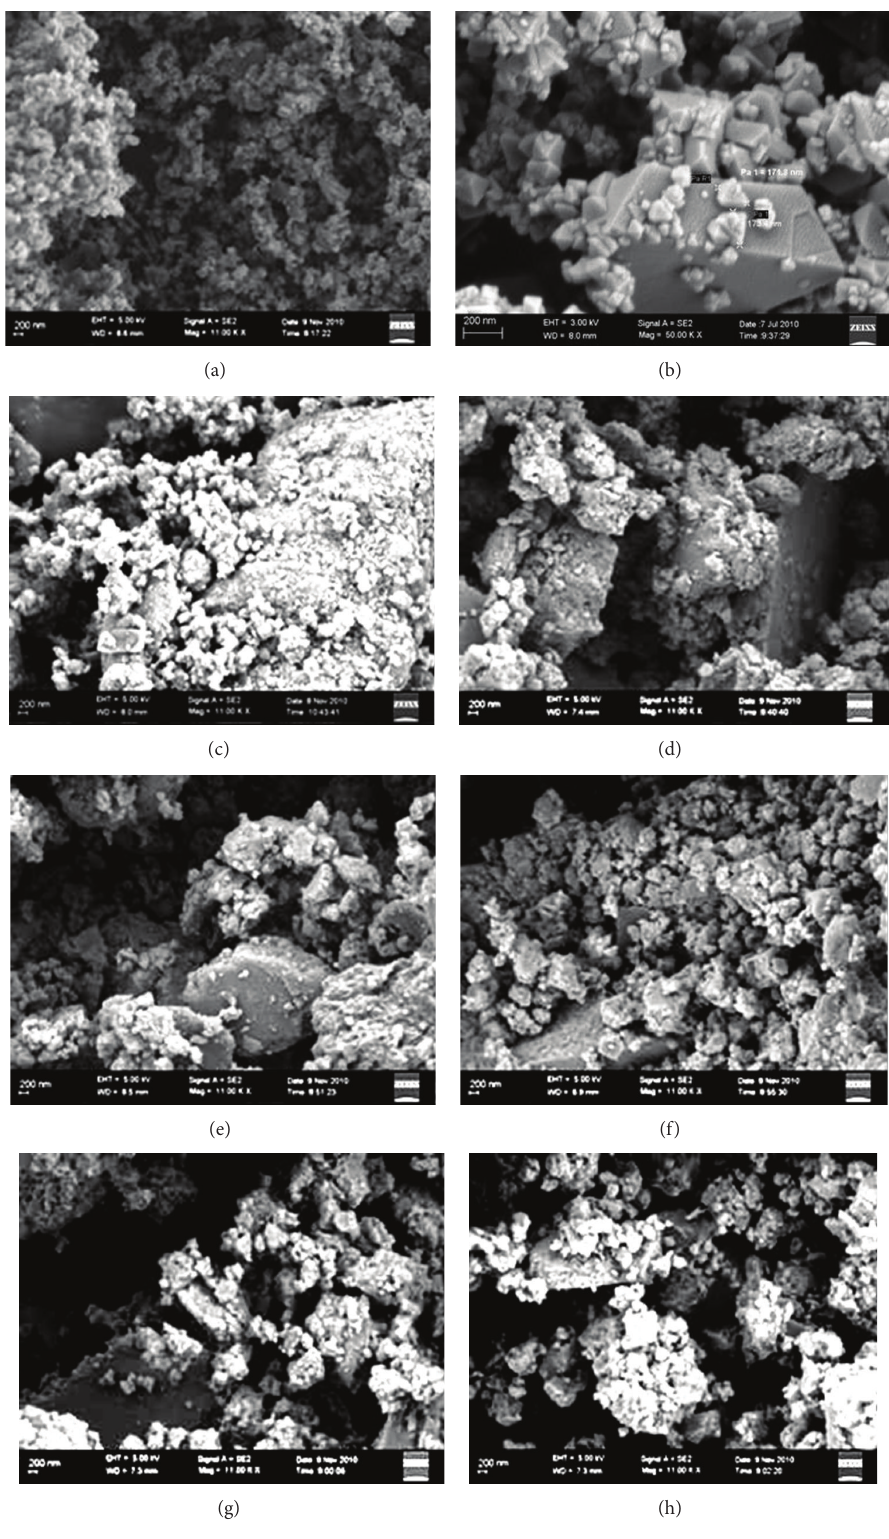
Figure 6: Scanning electron micrograph (SEM) images of (a) Fe 3 O 4 powder prior to milling at high magnification (50 00K X), (b) Fe 3 O 4 powder prior to milling at low magnification (11 00K X), (c) 20: 1 BPR, (d) 30: 1 BPR, (e) 40: 1 BPR, (f) 50 :1 BPR, (g) 60 :1 BPR, (h) 100:1